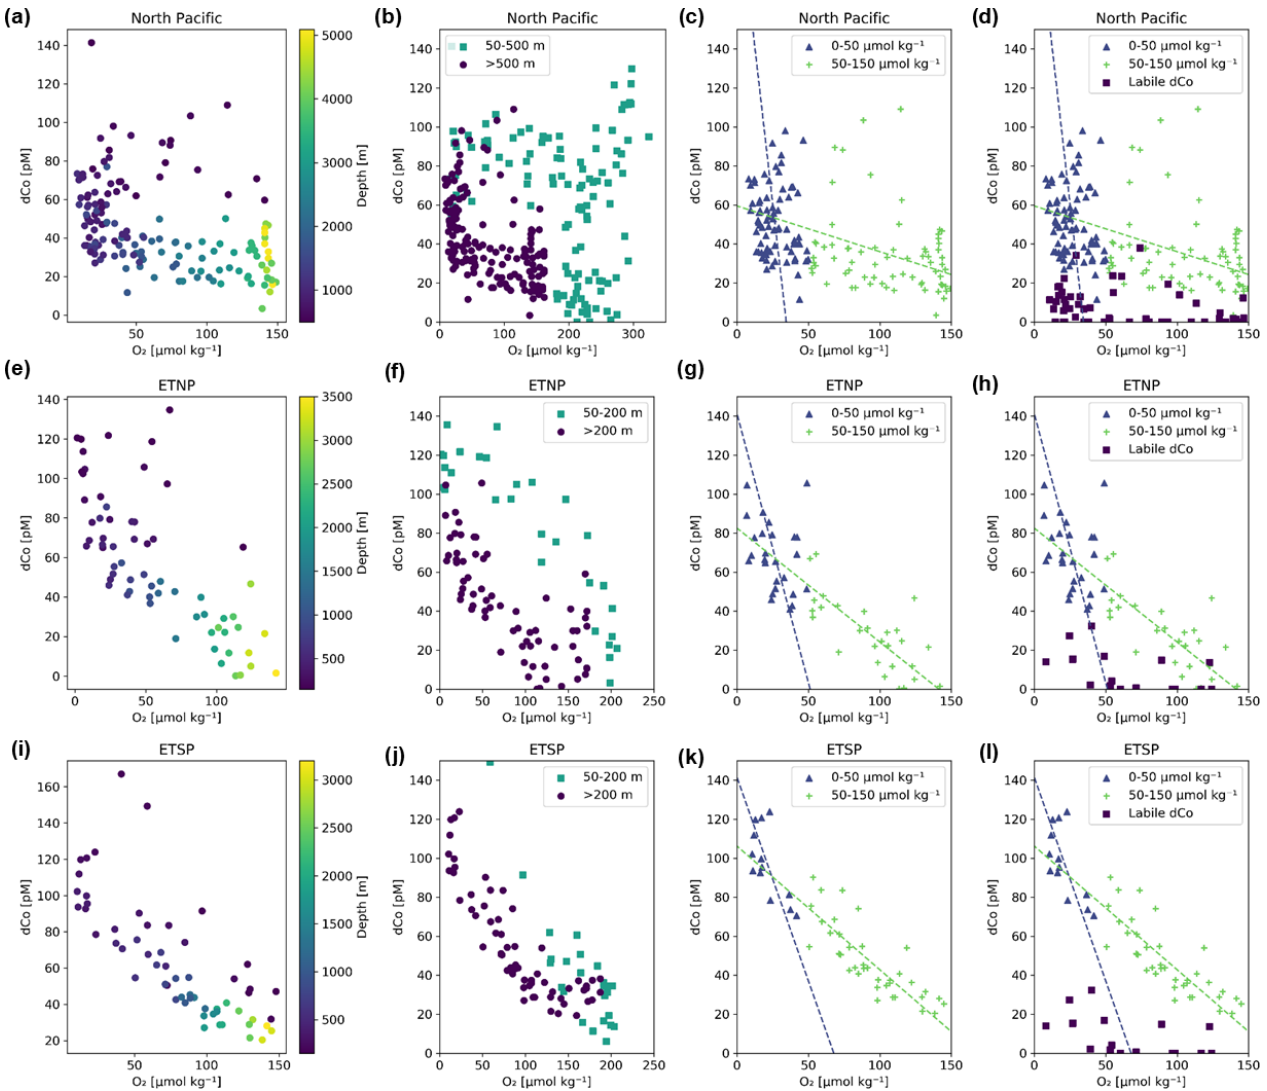
Figure A1. Interpretations of the dCo:O 2 relationship in the North Pacific ( a–d ; Stations 3–18), ETNP ( e–h ; Stations 20–25) and ETSP ( i–l ; Stations 29–34). Subplots (a) , (e) and (i) show dCo vs. O 2 where depth ≥ 500m in the North Pacific and depth ≥ 200m in the ETNP and ETSP. Subplots (b) , (f) and (j) include shallower samples above the 500m depth threshold in the North Pacific and 200m depth thresh- old in the ETNP and ETSP. Subplots (c) , (g) and (k) separate the dCo vs. O 2 correlations by O 2 concentration, with lower [O 2 ] samples ( < 50µmolkg − 1 ) displaying more negative slopes than samples where 50 ≤ [O 2 ] ≤ 150µmolkg − 1 . This trend suggests that low-[O 2 ] sam- ples, which tend to occur at shallower depths, are affected by more vertical processes like remineralization and scavenging at the boundaries of the OMZ core compared to mid-[O 2 ] samples, which are affected by more horizontal processes of advection and mixing. Two-way re- gression statistics are given in Table A1 above. Subplots (d) , (h) and (l) include labile dCo concentrations and suggest that labile dCo might be more prevalent in the low-[O 2 ] samples and could be scavenged in more oxic waters. The labile dCo concentrations appear to be affected by additional processes in the North